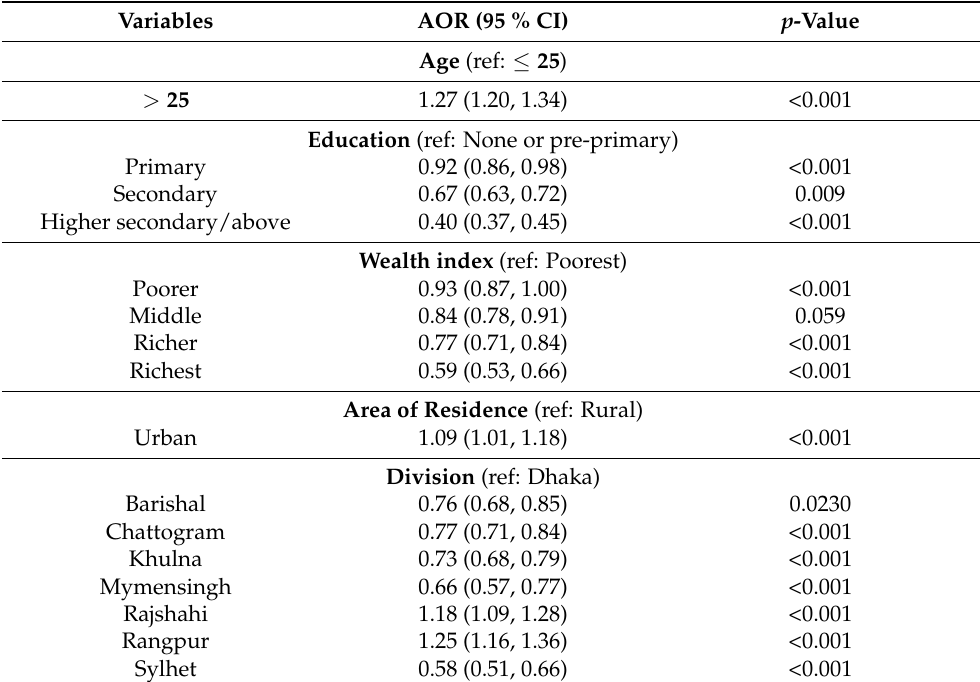
Table 3. Association between socio-demographic characteristics and attitude toward acceptance of IPV among women in Bangladesh: Results (adjusted) from logistic regression